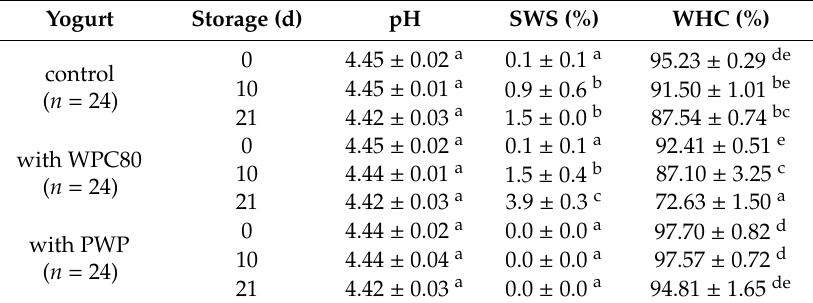
Table 3. Syneresis of yogurt with increased whey proteins content, including whey proteins after the polymerization process. Yogurt Storage (d) pH SWS (%) WHC